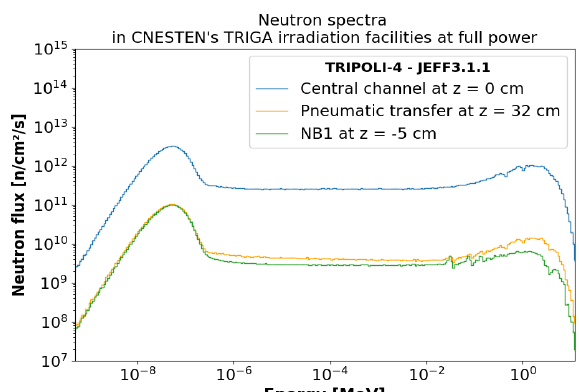
Fig. 8. Neutron spectra in the Central Channel (CC), Pneumatic Transfer System (PTS) and the tangential channel